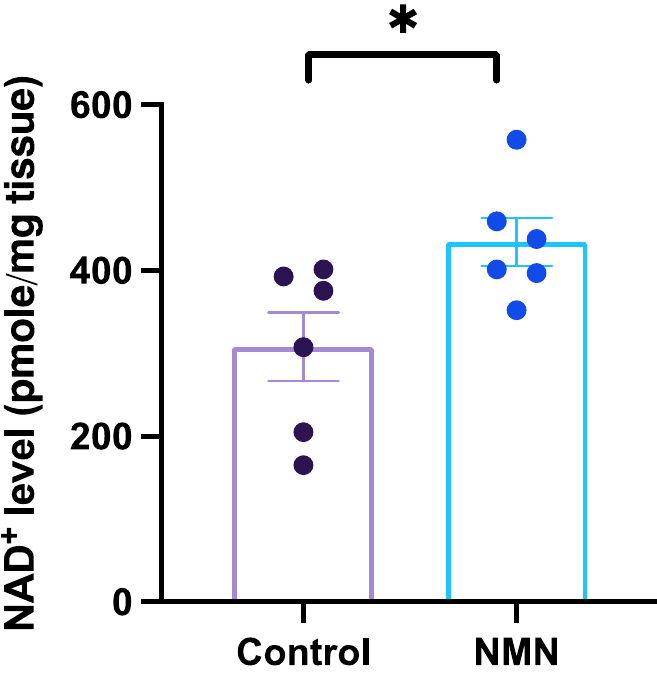
Figure 1. Oral gavage administration of nicotinamide mononucleotide (NMN) increases nicotinamide adenine dinucleotide (NAD +) in brain tissue of mice. Data are expressed as mean ± SEM. The histogram depicts the NAD + level in the brain tissues of NMN (400 mg/kg) and PBS (control) administrated mice 45 min after oral gavage. * indicates p =